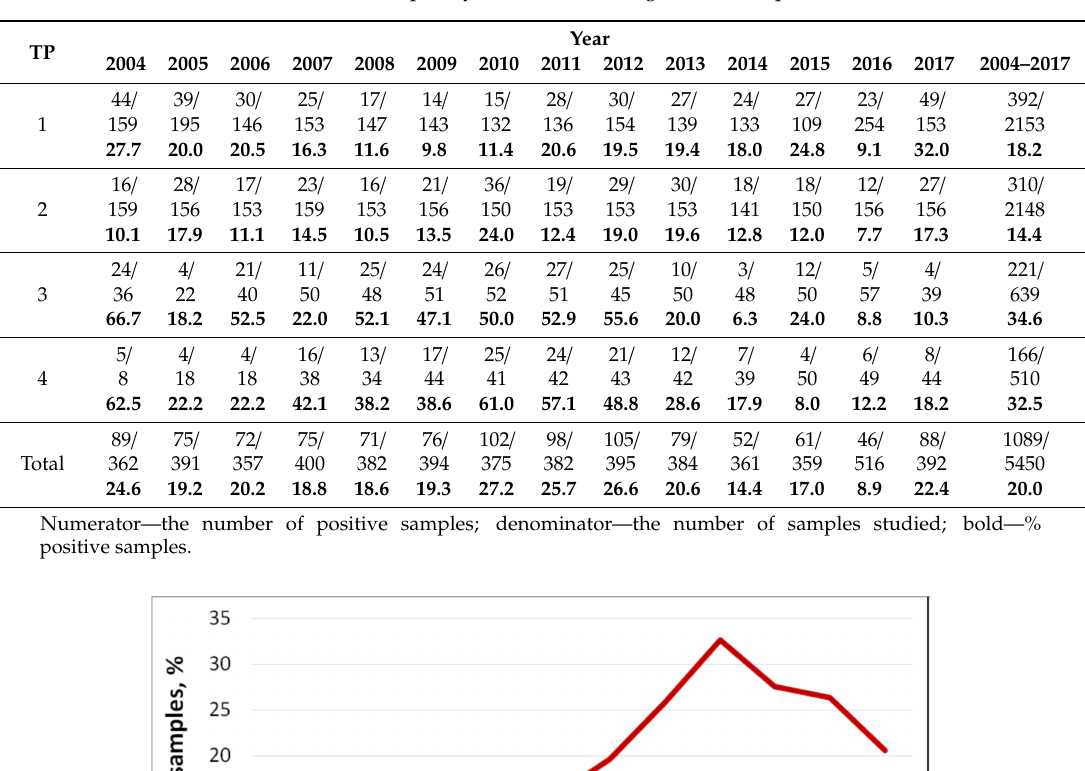
Table 1. Enterovirus isolation frequency at Moscow sewage treatment plants (TP), 2004–2017.